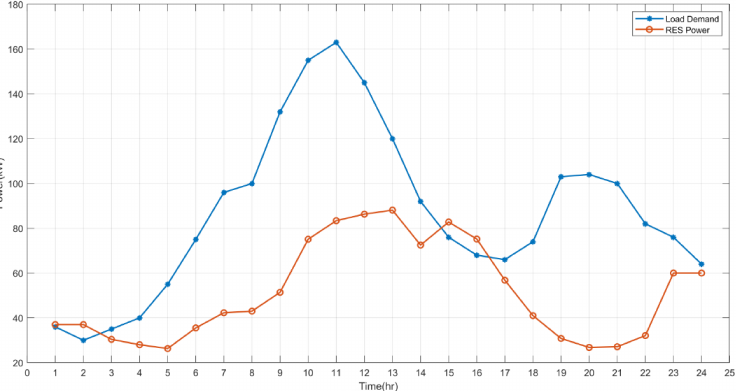
Figure 4. A residential demand profile and a wind power profile.